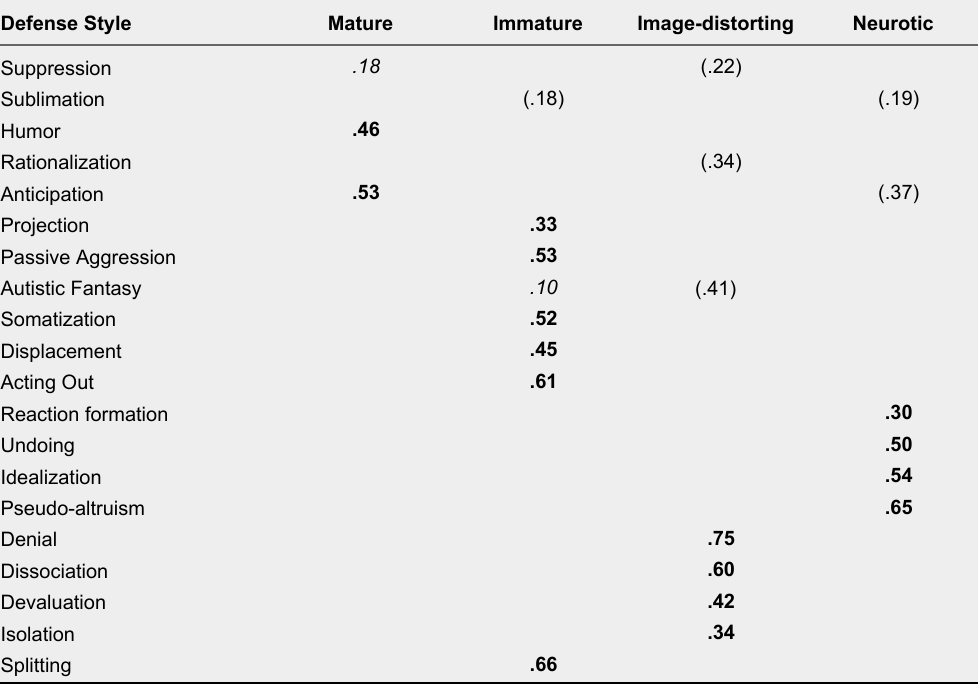
Exploratory Factor Analysis Pattern Coefficient Matrix (4-Factor